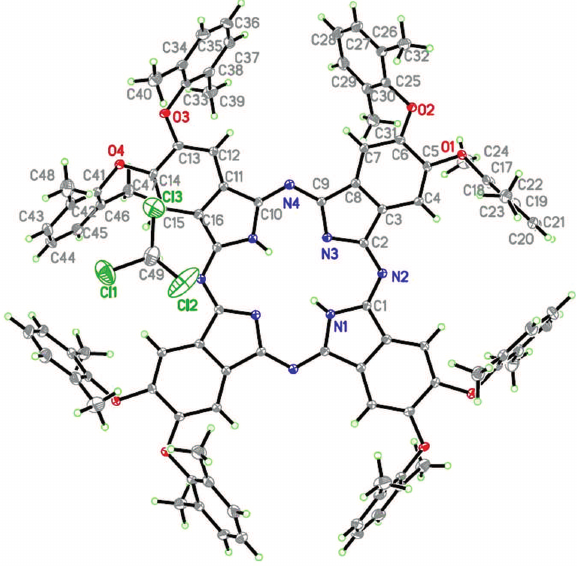
Table 1: Data collection and